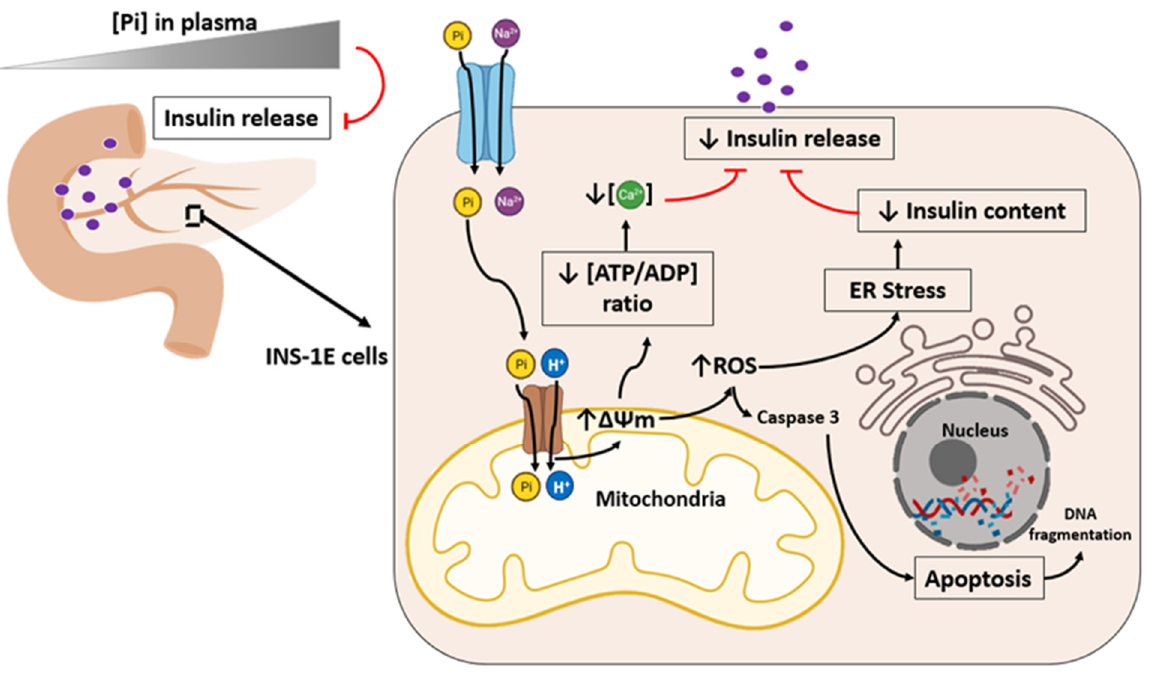
Figure 3. High phosphate induces ROS production and impairs insulin secretion. It has been demonstrated that decreased insulin content and secretion are correlated under hyperphosphataemic states (elevated plasma Pi concentrations). Elevated extracellular Pi (1–5 mM) increases the mitochondrial membrane potential ( ∆Ψ m), superoxide generation, caspase activation, and cell death [56]. Elevated extracellular Pi diminishes ATP synthesis, cytosolic Ca 2+ oscillations, and insulin content and secretion in INS-1E cells and dispersed islet cells [56]. In addition, Pi-induced superoxide production promotes endoplasmic reticulum (ER) stress, which decreases insulin content, impairing insulin release [57]. Solid black arrows indicate activation. Solid red traces indicate inhibition.